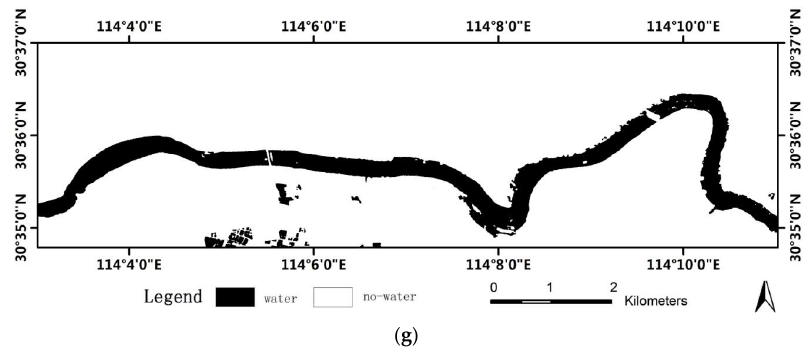
Figure 6. Segmentation results (Hanjiang River). ( a ) SWR region generated by Figure 4d; ( b ) Manual segmentation; ( c – e ) LSW map obtained using ALG1, ALG2 and ALG3,respectively; ( f ) LSW map obtained using our method; ( g ) LSW map obtained after post-processing.